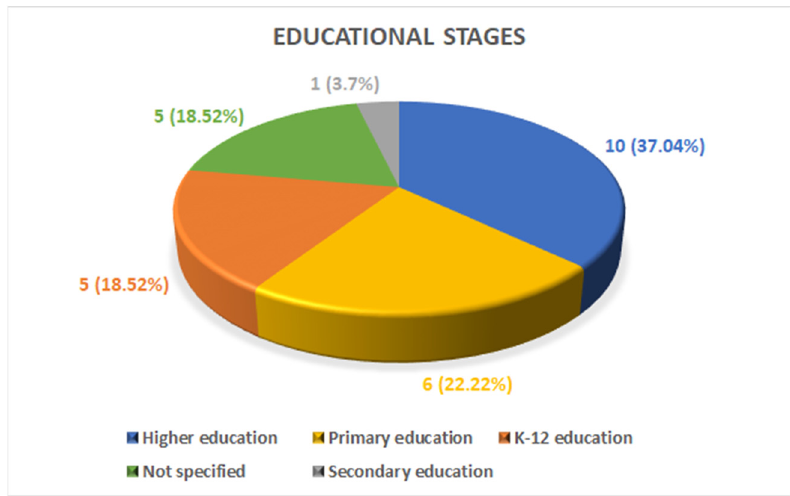
Figure 8. Proposal and prototype papers: educational stages.